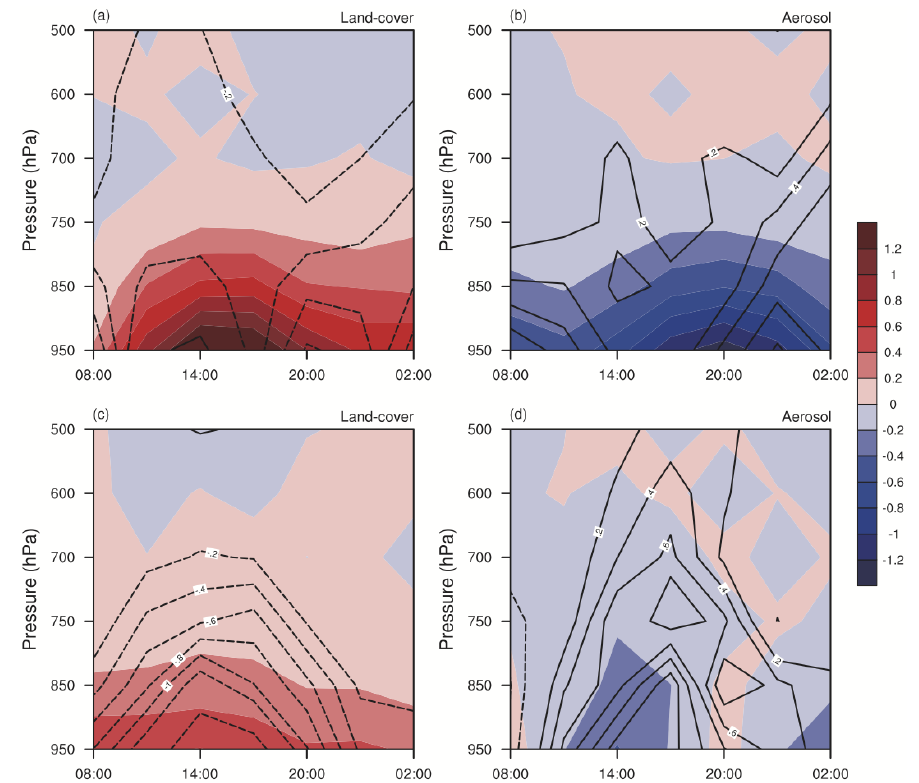
Figure 15. Same as Fig. 14 but for differences in the CON term (shaded; units: 10 − 4 g − 1 kg − 1 s − 1 ) and MA term (black lines; units: 10 − 4 g − 1 kg − 1 s − 1 ) in Eq.